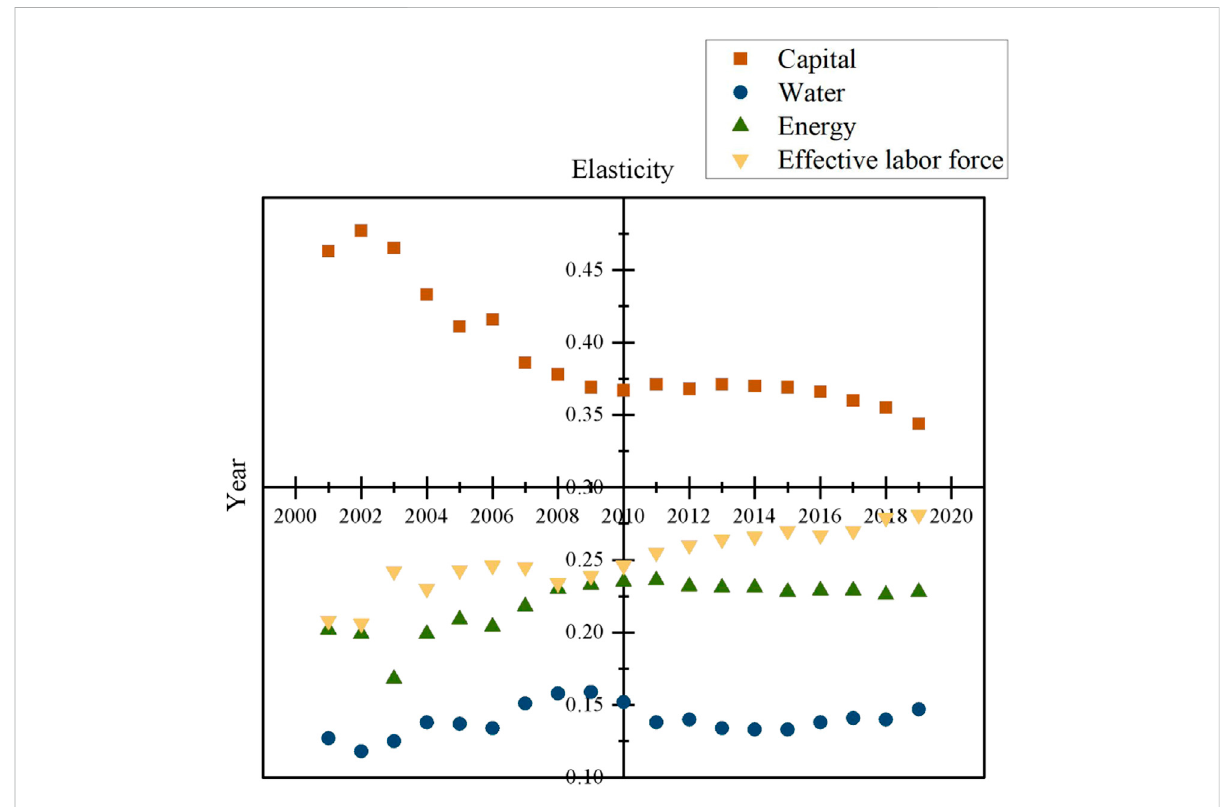
FIGURE 1 Elasticity coef fi cients variables from 2001 to 2019.